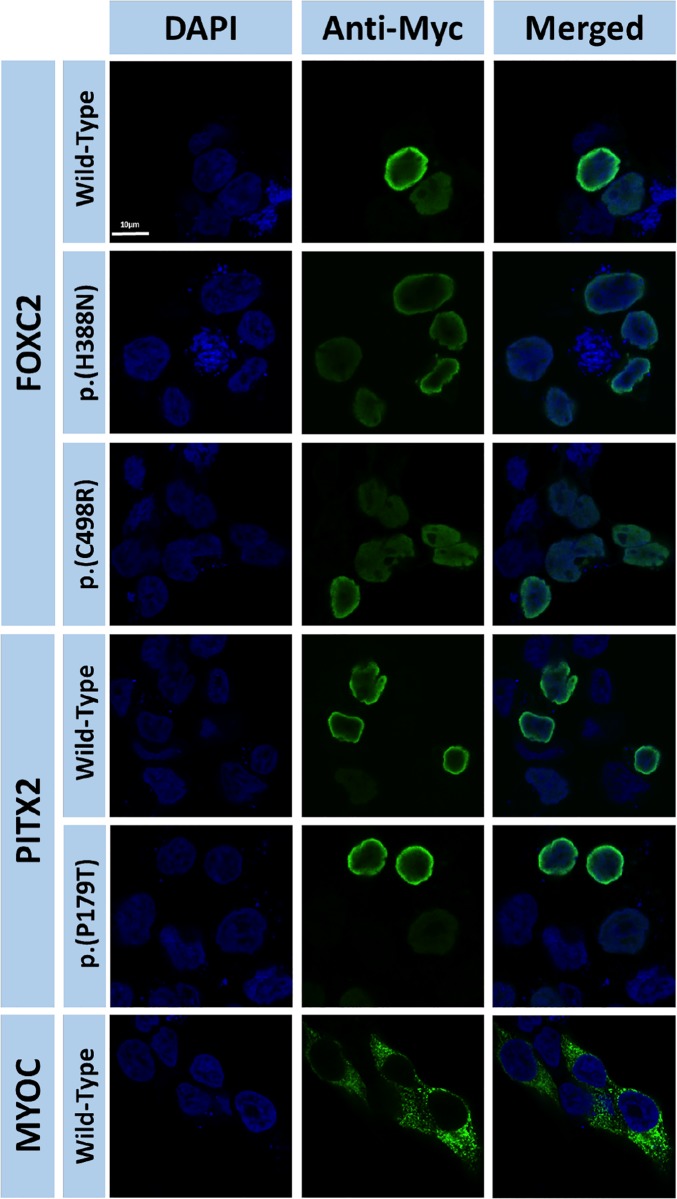
Coding FOXC2 and PITX2C variants identified in this study do not alter subcellular localization in cells in culture.cDNA constructs encoding the indicated recombinant versions of FOXC2 and PITX2C were transiently expressed in HEK-293T cells. The recombinant proteins were detected by fluorescent immunocytochemistry with an anti-myc antibody (Santa Cruz). Nuclei were visualized by fluorescent DAPI staining. Original magnification: X600.